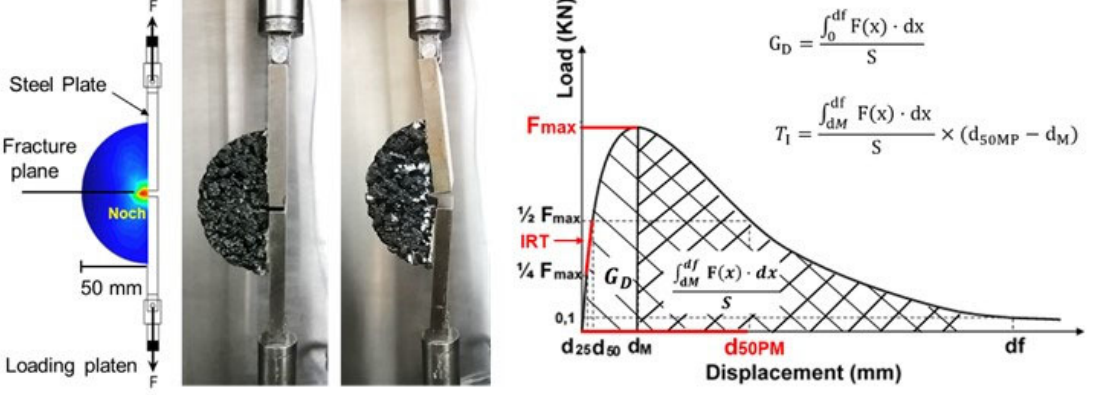
Figure 8. Fénix test setup and load ‐ displacement output test curve. Figure 8. F é nix test setup and load-displacement output test